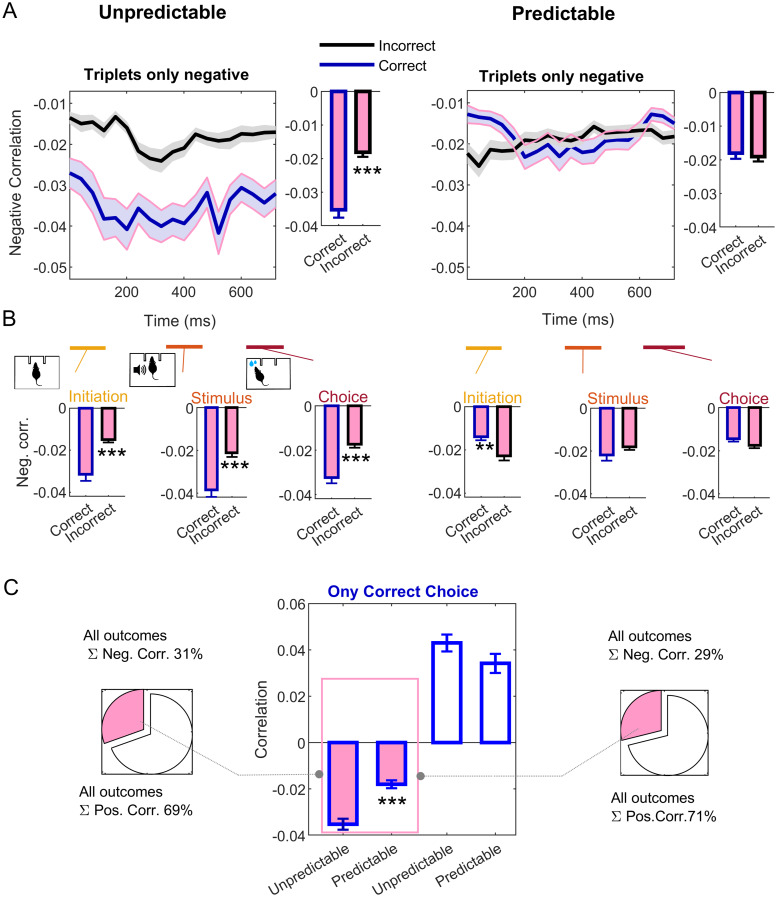
Negative triplet-wise correlations accompany the unsuccessful decoding of correct choices for unpredictable stimuli.(A) Negative correlations among triplets of units after correct (unpredictable, left) and after incorrect (predictable, right) trial choice outcomes, averaged across all ensembles used in Fig 5. Correct choices are shown in blue, incorrect choices in black; shaded areas are SD. Insets show the average through the entire trial duration. Magenta filling is used through the figure to indicate negative correlations. (B) Averages for the periods of interest defined in Fig 1A: trial initiation (left), stimulus offset (central) and choice (right). (C) Total fraction of positive and negative correlations for all ensembles and trials after correct (unpredictable, left) and after incorrect (predictable, right) trial choice outcomes. The center panel show the averaged correlation only for correct choices. ** p < 0.001, *** p < 0.0001; test details in the main text. See Fig 7 for partial triplet-wise correlations and S4 Fig for pairwise correlations. See also S5 Fig for a complementary index.